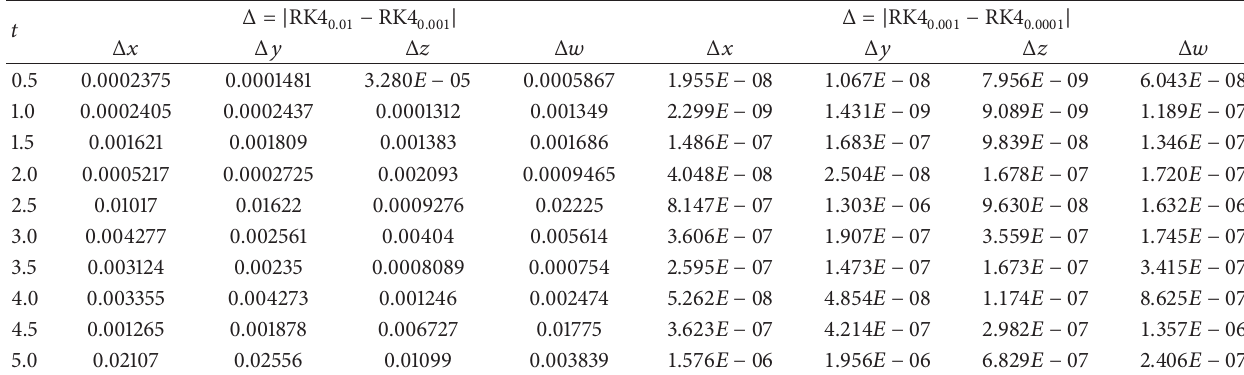
Table 2: Determination of accuracy of RK4 for hyperchaotic L¨u system for Case 1